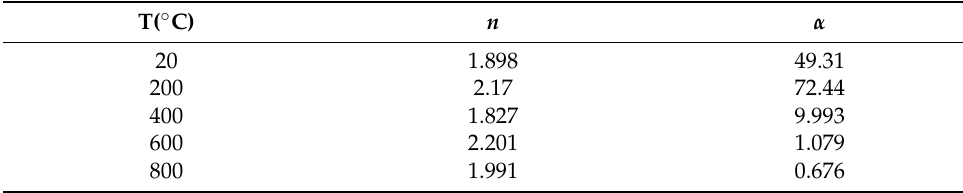
Table 6. Parameters of constitutive equation for post-fire